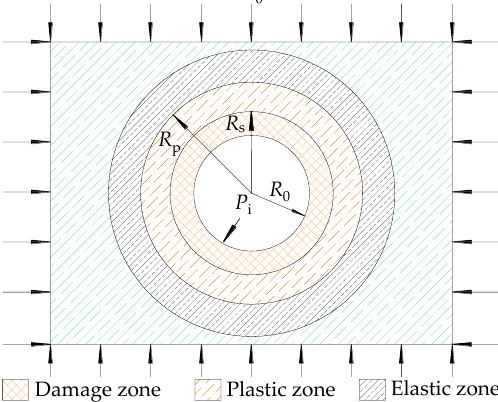
Figure 5. Zones in the main roadway surrounding rock.